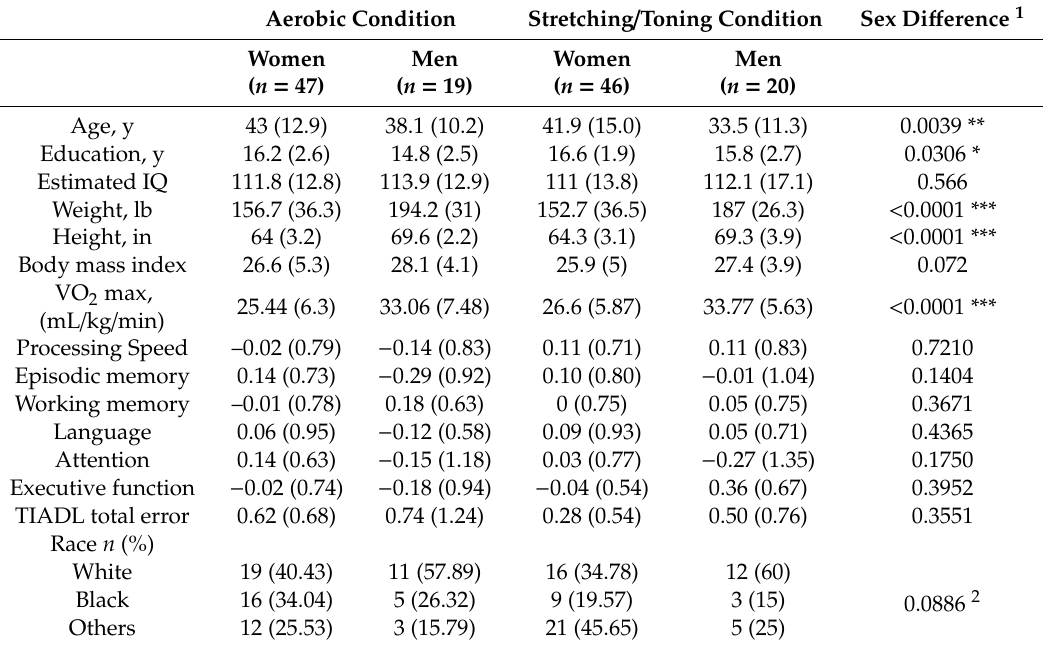
Table 1. Baseline characteristics of the